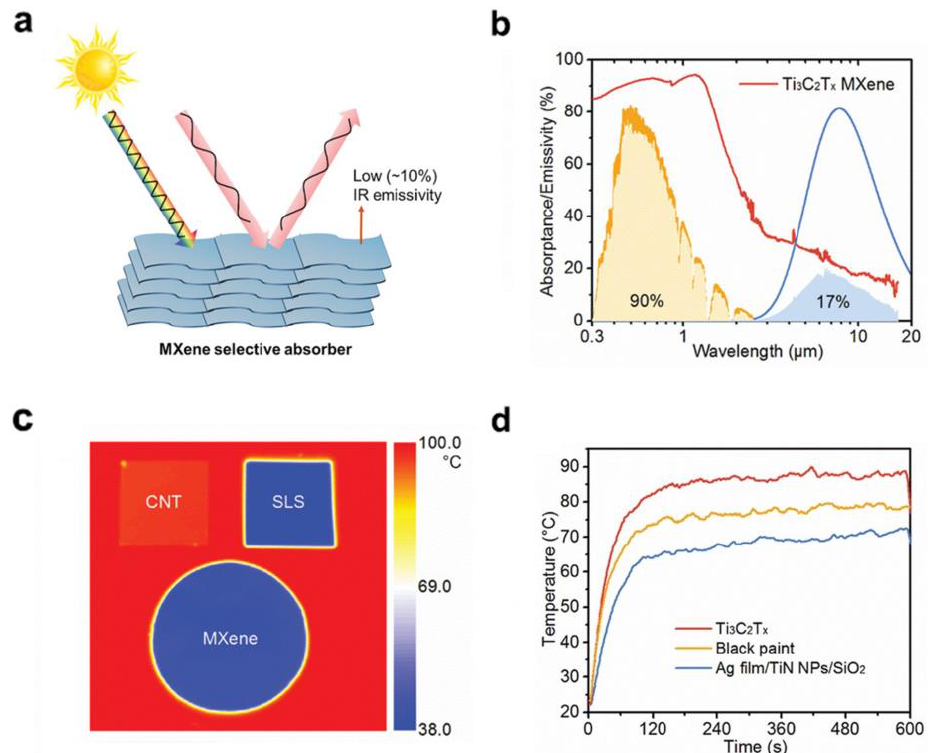
Figure 5. Light–matter interaction of MXene materials. ( a ) The high solar absorptance, high mid–IR reflectance, and low IR emissivity of MXenes; ( b ) Absorptance/emissivity spectra of a Ti 3 C 2 T x film; ( c ) IR photographs of the SLS, CNT, and MXene on a hot plate with a constant temperature of 100 ◦ C; ( d ) Temperature versus time of Nylon 66 membranes coated with Ti 3 C 2 T x and metamaterial absorbers under 1 sun. (Reprinted with permission from Ref. [79]. 2021 John Wiley and Sons).